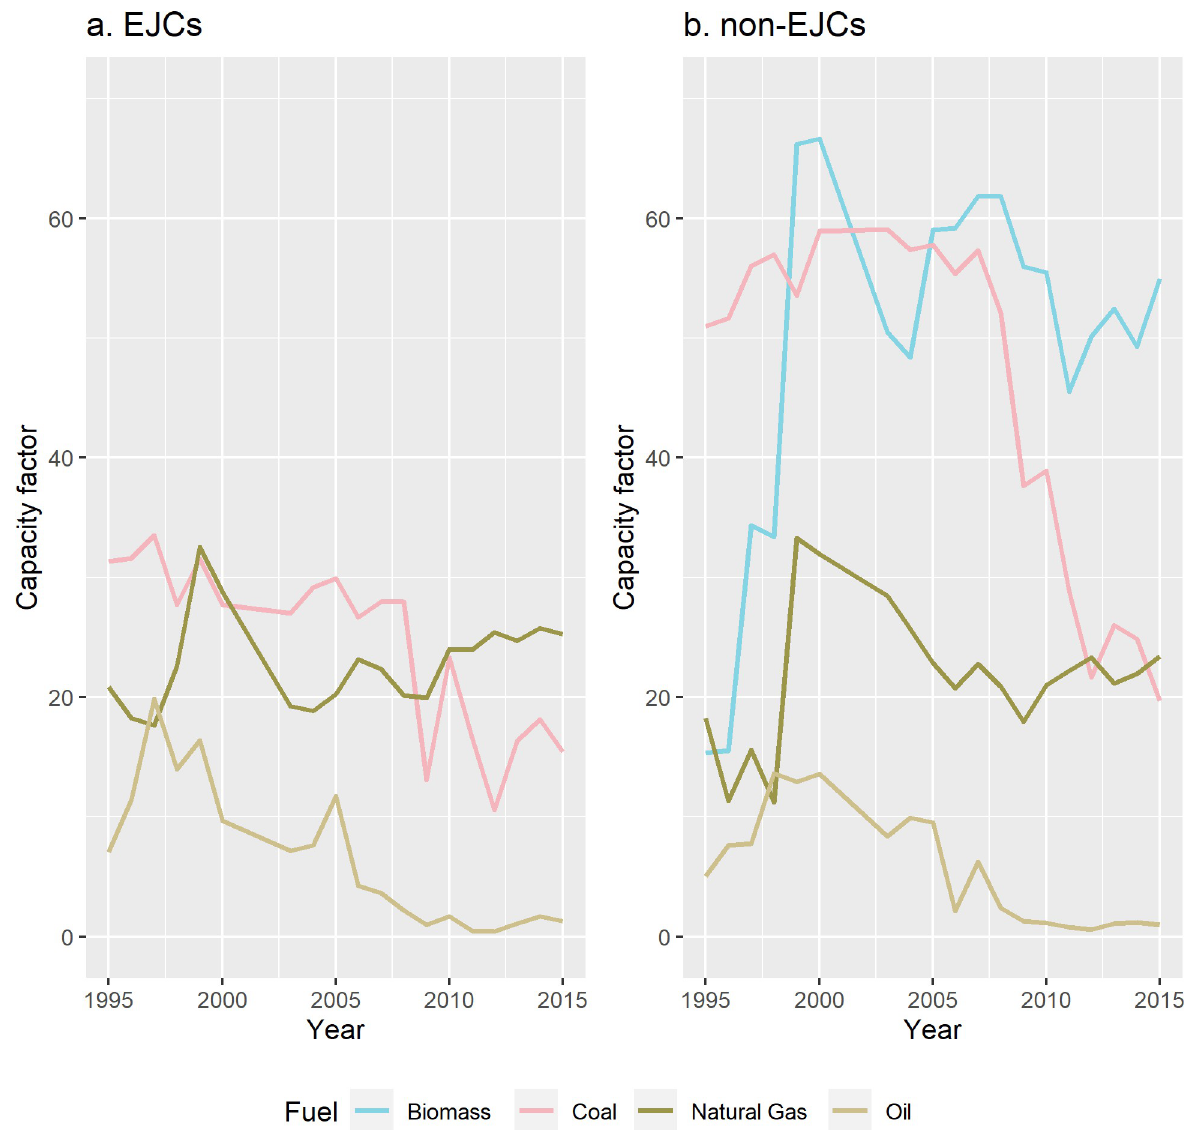
Fig 6. Mean capacity factor by fuel type in EGUs in RGGI sited in (A) EJCs and (B) non-EJCs. EGUs that did not report fuel type also did not report capacity factors and are thus